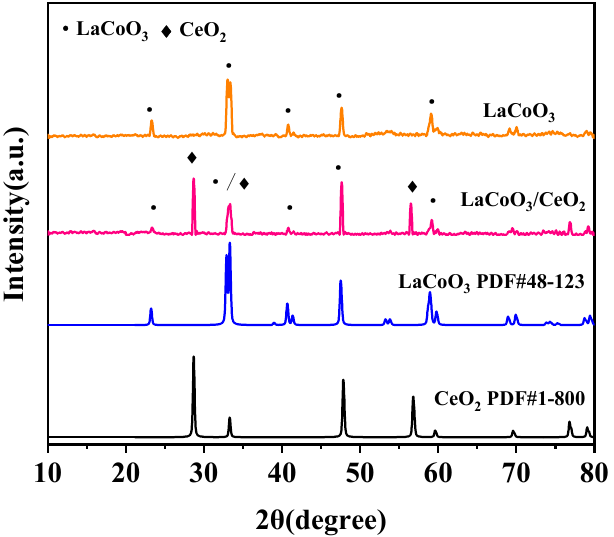
Figure 5. XRD patterns of LaCoO 3 catalysts with different supports. (Catalyst preparation conditions: calcination temperature = 800 °C, calcination time = 8 h).